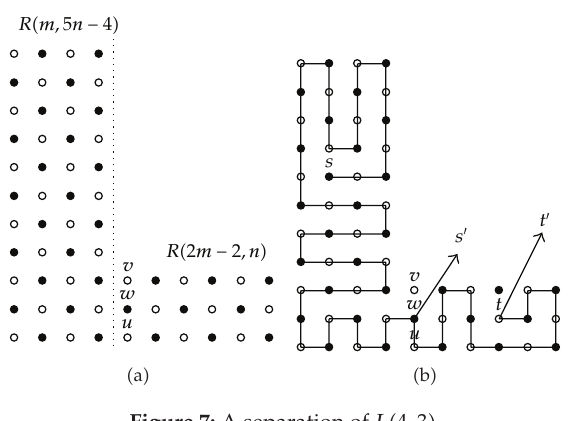
Figure 7: A separation of L (cid:6) 4 , 3 (cid:7)